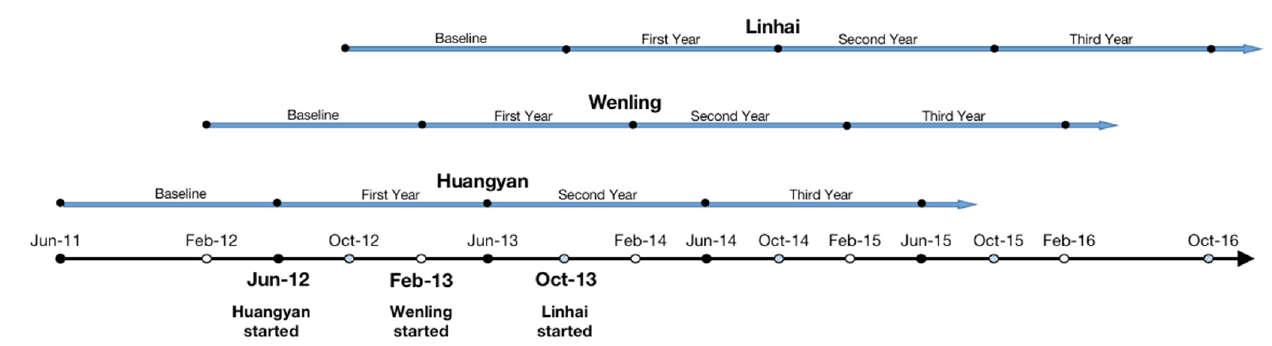
Figure 1. Study timeline of the full coverage policy for essential medicines in three districts in Taizhou, China.